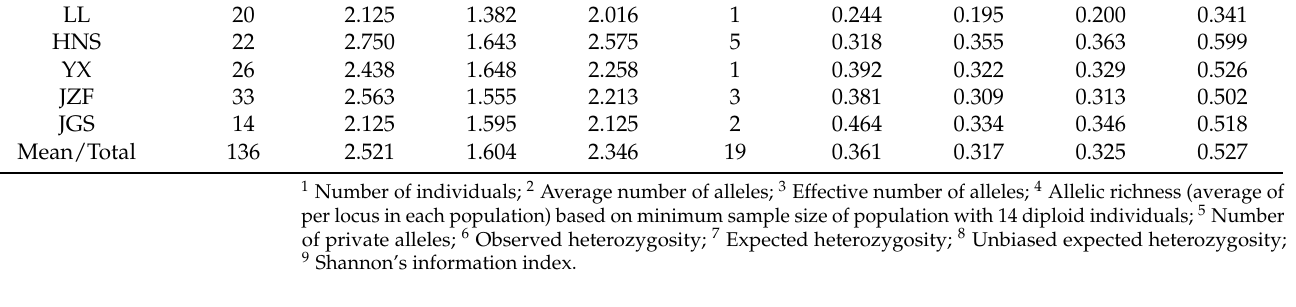
Table 4. Result of AMOVA for S. tzumu .